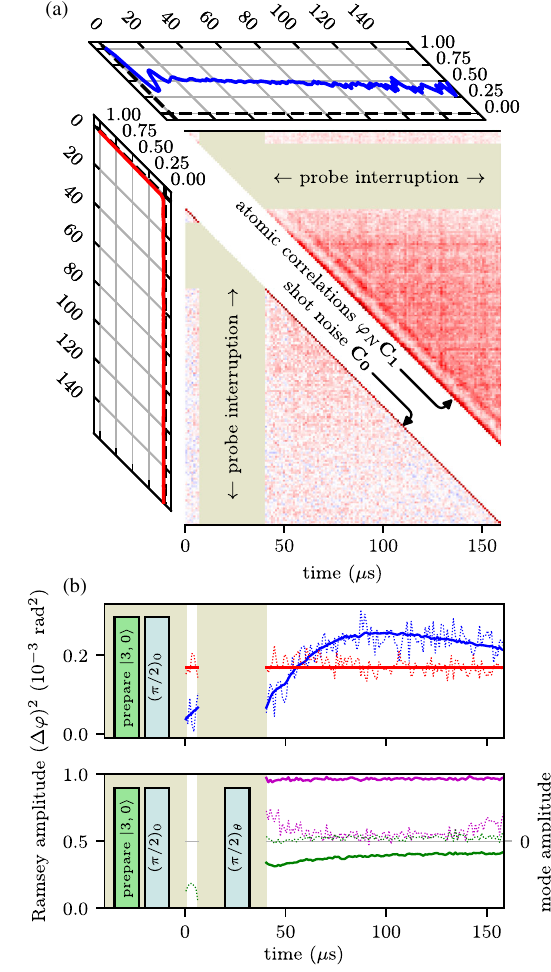
FIG. 3. (a) Constant part C 0 (lower left-hand triangle: shot noise) and linear part φ N C 1 (upper right-hand triangle: atomic correlations) of the symmetric covariance matrix C ¼ C 0 þ φ N C 1 for φ N ¼ 0 . 16 ð 1 Þ rad (see text); red (blue) denotes positive (negative) correlations. Shaded areas indicate interruption of the probing. Side panels: Correlation coefficient obtained by averaging over the minor diagonals of the corresponding matrix of correlation coefficients. (b) Upper panel: QND pulse sequence; temporal dependence of the main diagonal entries of C 0 (constant part, red dots) and of φ N C 1 (atom number dependent part, blue ; solid red line, phase dots). Solid blue line, ð φ N ⃗ m ð t Þ = 2 Þ 2 =N eff 2 . Lower panel: Ramsey-type pulse sequence and shot noise δφ sn temporal evolution of the Ramsey fringe contrast in the absence (solid purple) or presence (solid green) of an 8 μ s probe pulse. Dotted traces denote the corresponding optimal detection mode